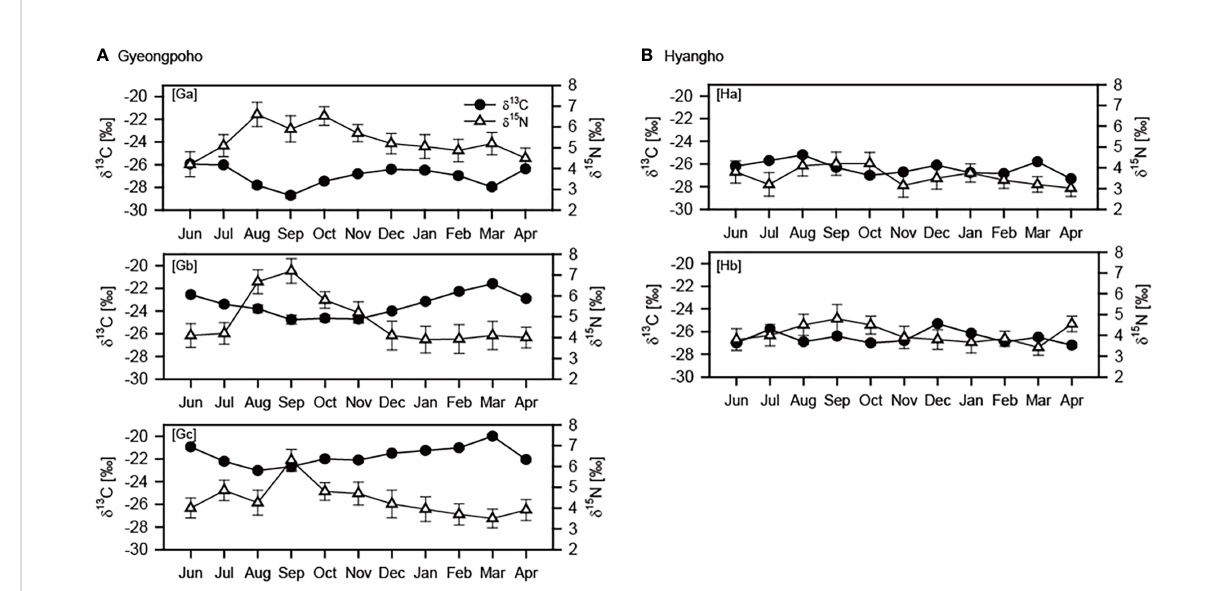
FIGURE 5 Monthly variations in d 13 C and d 15 N variations at study sites in Gyeongpoho (A) and Hyangho (B) during sampling